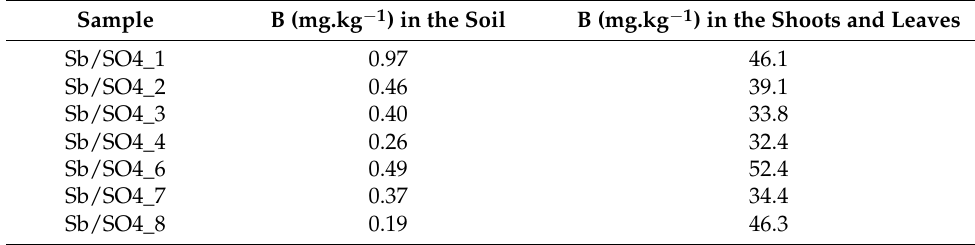
Table 2. The boron content measured in the soil, shoots, and